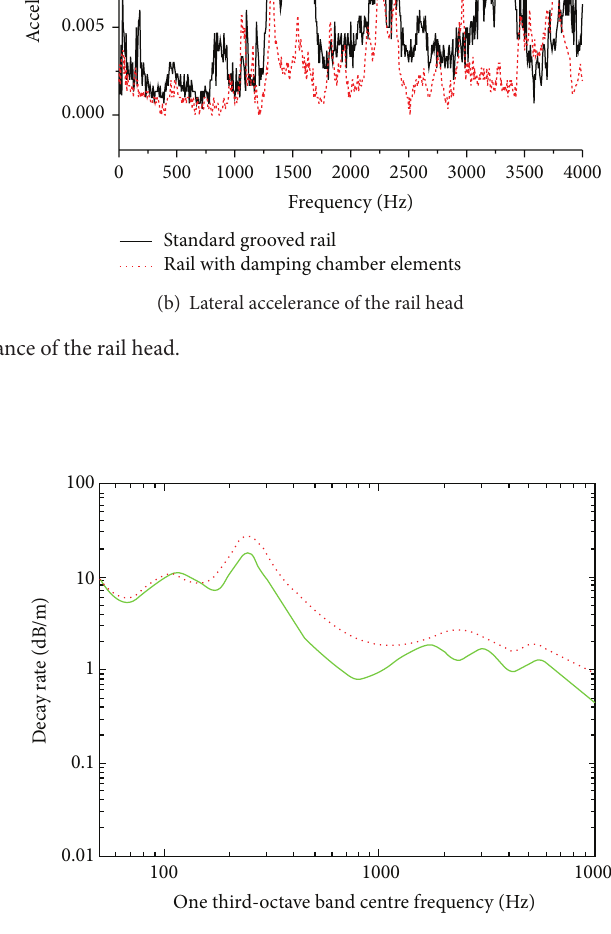
Figure 16: Measured track decay rates: standard grooved rail (green line) and rail with damping chamber elements (red